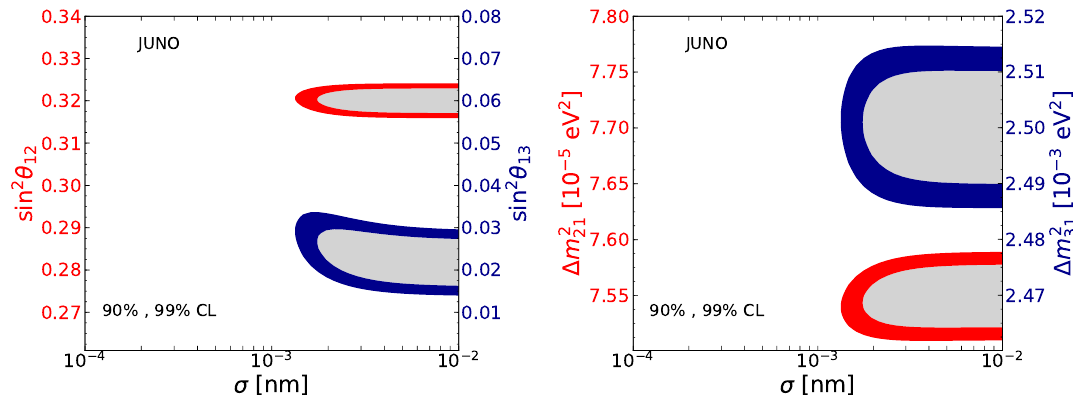
Figure 5 . 90 and 99% CL (2 d.o.f.) allowed regions in the (cid:27) -mixing angle (left) and (cid:27) -(cid:1) m 2 planes obtained by analyzing simulated JUNO data consistent with no decoherence ( (cid:27) ! 1 ) . The red (blue) contours have to be compared with the red (blue) axes in both panels. The input values for the standard oscillation parameters are listed in eqs.